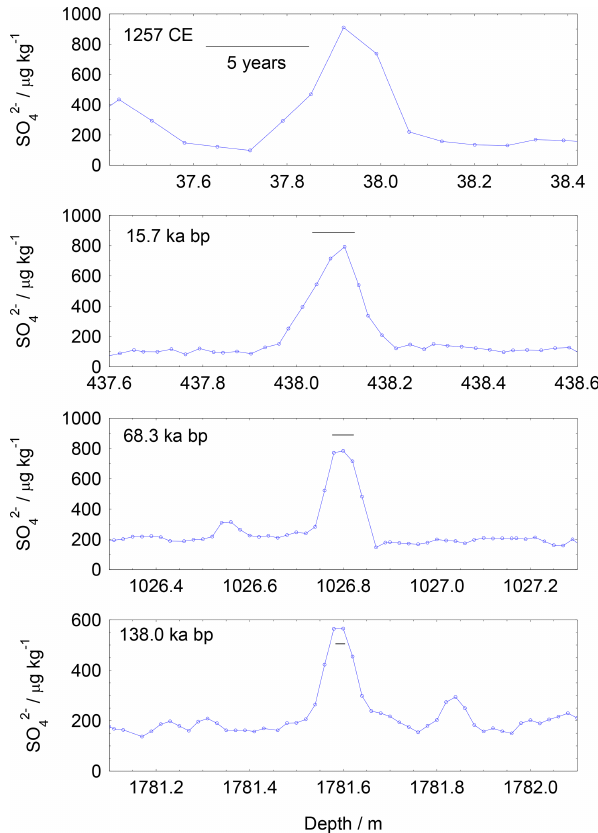
Figure 2. Examples of volcanic peaks at different depths and ages. The 1257 peak (top panel) is shown after application of the correc- tion described above. The black horizontal bar on each plot repre- sents 5 years at each depth. Dots represent the mid-depths of indi- vidual samples.